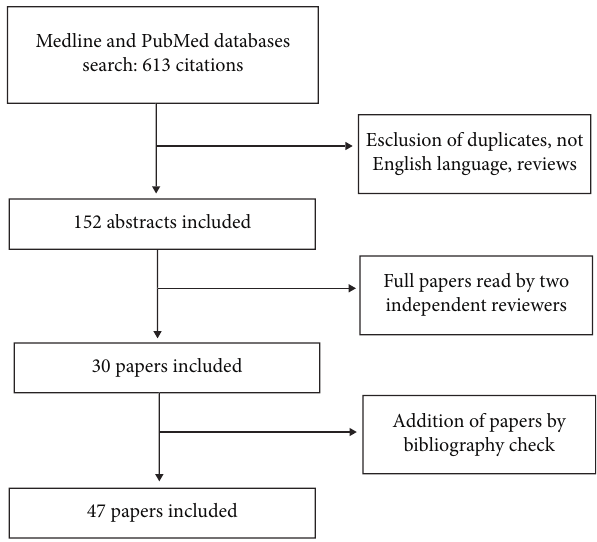
Figure 1: Flowchart of papers